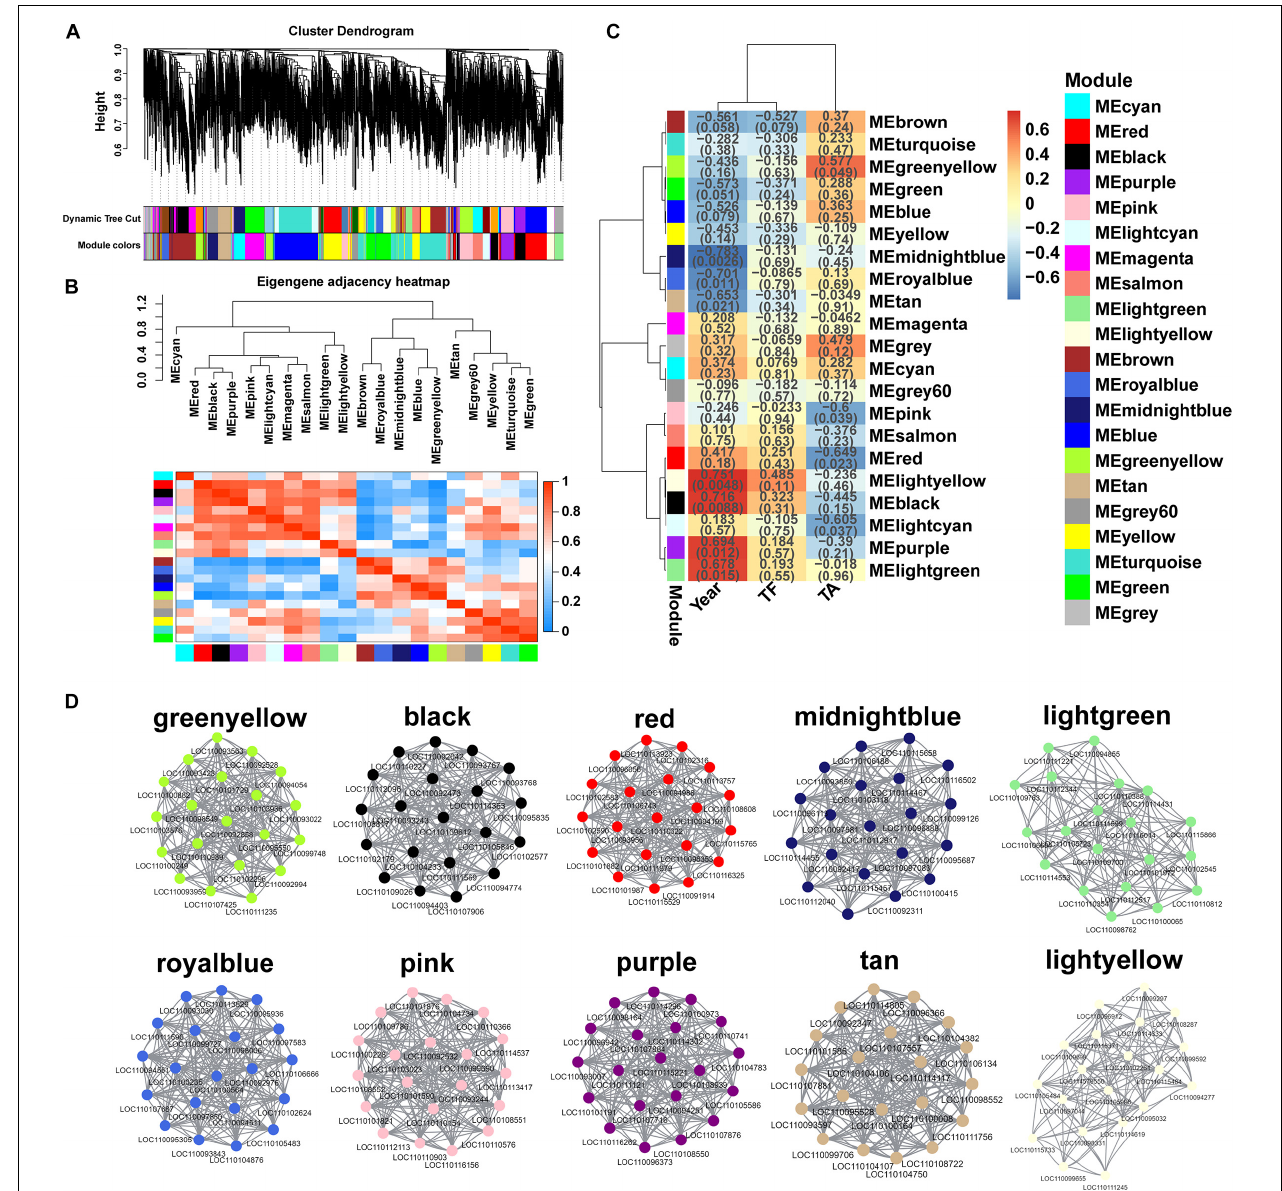
FIGURE 7 | Weighted gene co-expression network of D. huoshanense . (A) Clustering dendrogram of DEGs, with dissimilarity based on the topological overlap, together with assigned module colors. The clustered branches represent different modules, and each line represents one DEG. (B) The heatmap of connectivity of eigengenes. (C) Module-trait associations. Each row corresponds to a module characteristic gene (eigengene), and each column corresponds to a trait. Each cell contains a corresponding correlation coefficient and p -value. (D) Visualization of network relationships of hub genes in 10